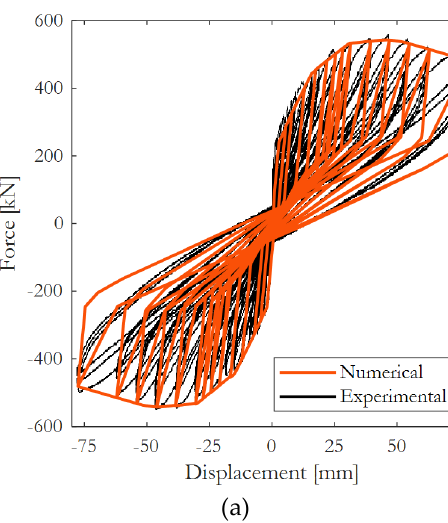
Figure 10. Numerical versus experimental test results for masonry infill type 4 [5]: ( a ) without openings and ( b ) with openings.